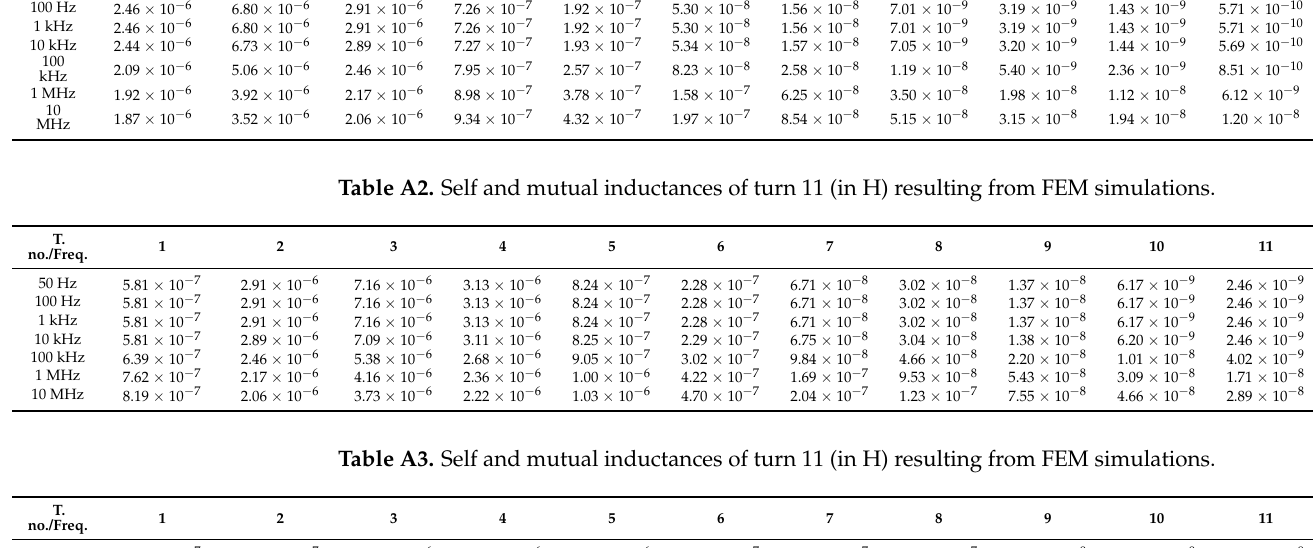
Table A1. Self and mutual inductances of turn 11 (in H) resulting from FEM simulations. T. no./Freq.